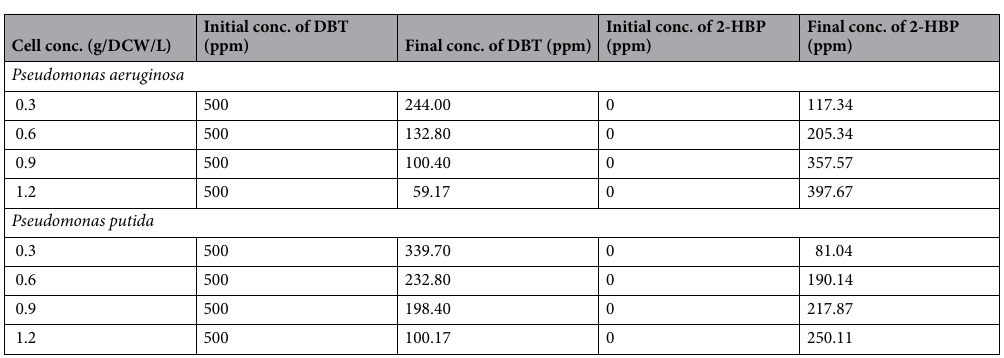
Table 2. Initial and final concentrations of DBT/2-HBP during biodesulfurization of DBT by Pseudomonas aeruginosa and Pseudomonas putida.